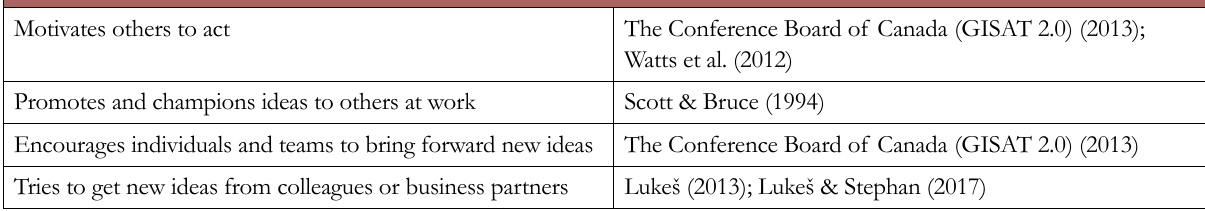
Table 12. Behaviours showing “moving others to act”